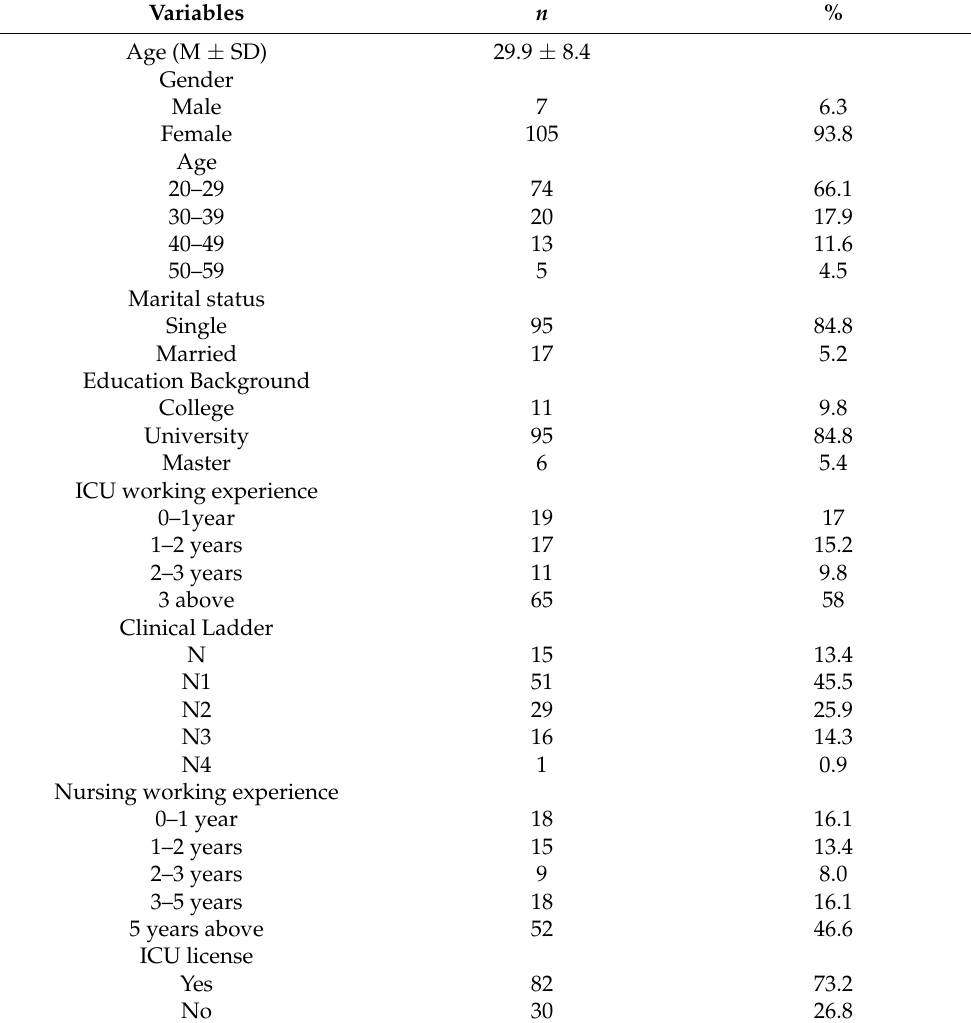
Table 1. Characteristics of the study participants ( n =